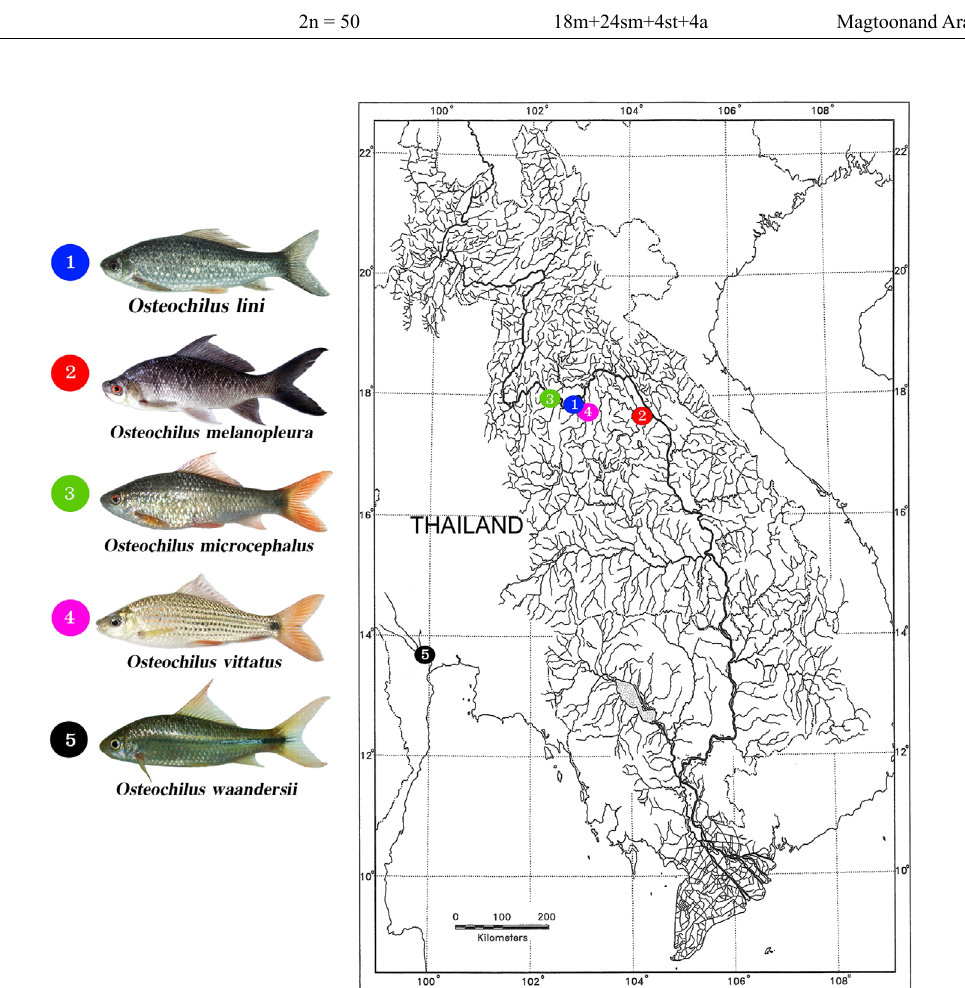
Figure 1 – Thailand map showing the collection sites of the five species studied. 1. Osteochilus lini (blue circles); 2. Osteochilus melanopleura (red circles); 3. Osteochilus microcephalus (green circles) ; 4. Osteochilus vittatus (pink circles); 5. Osteochilus waandersii (black circles). The maps were created using the following softwares: QGis 3.4.3, Inkscape 0.92 and Photoshop